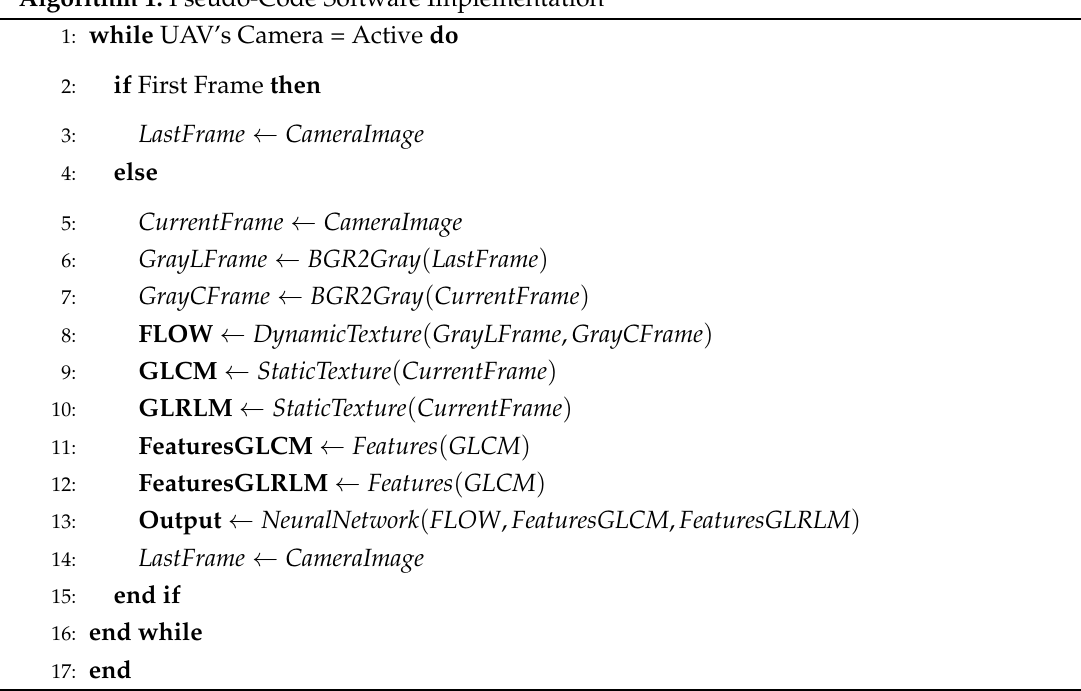
Algorithm 1: Pseudo-Code Software Implementation